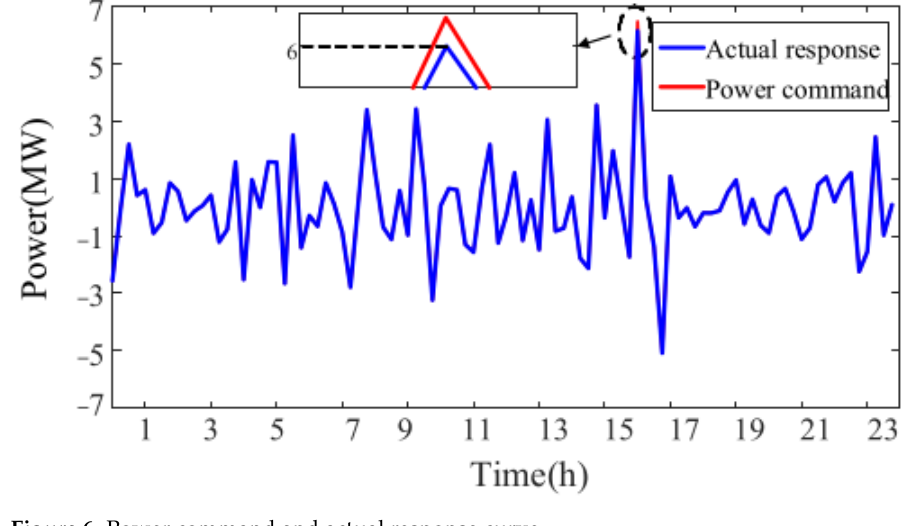
Figure 6. Power command and actual response curve.